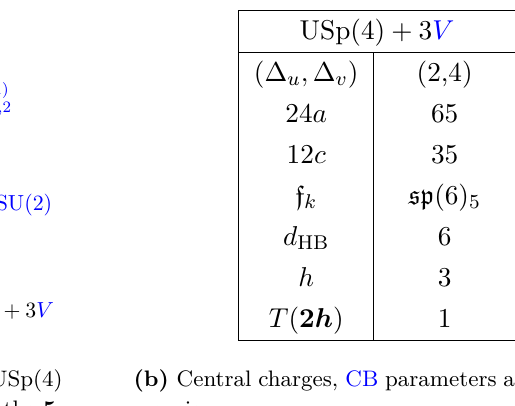
= sp (6) T × u (1) . This sp (8) c 4 5